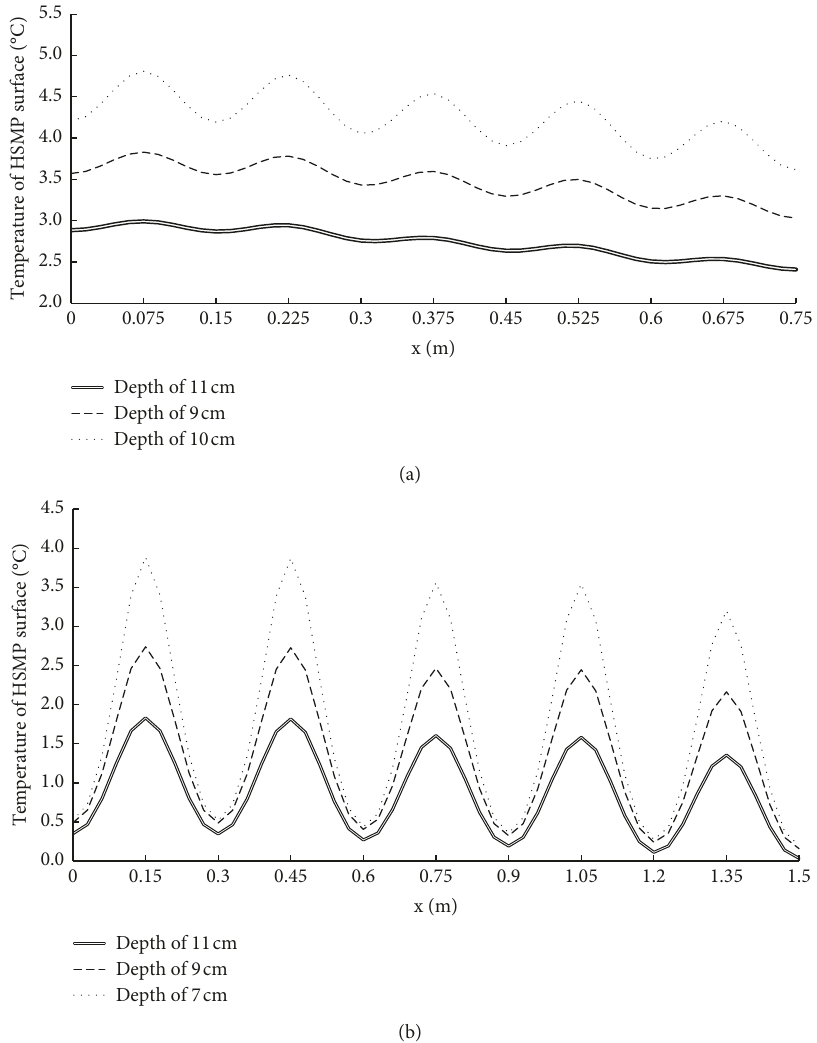
Figure 12: Temperature of HSMP surface at the outlet section with different pipe embedded depths: (a) pipe spacing of 15cm; (b) pipe spacing of